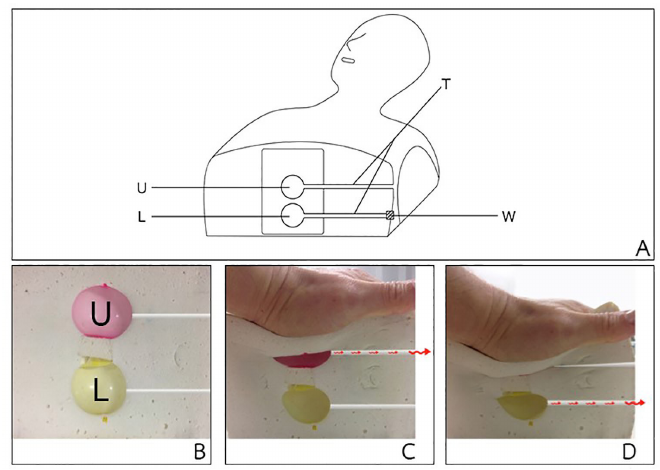
Figure 2. A, B, C, and D show the rubber foam cardiac mechanism: A) U = upper air space, L = lower air space, T = tube, W = whistle; B) cross-section of the pressure-sensing mechanism, U = upper air space, L = lower air space; C) beginning of chest compression; D) 1-2 inch depth of chest